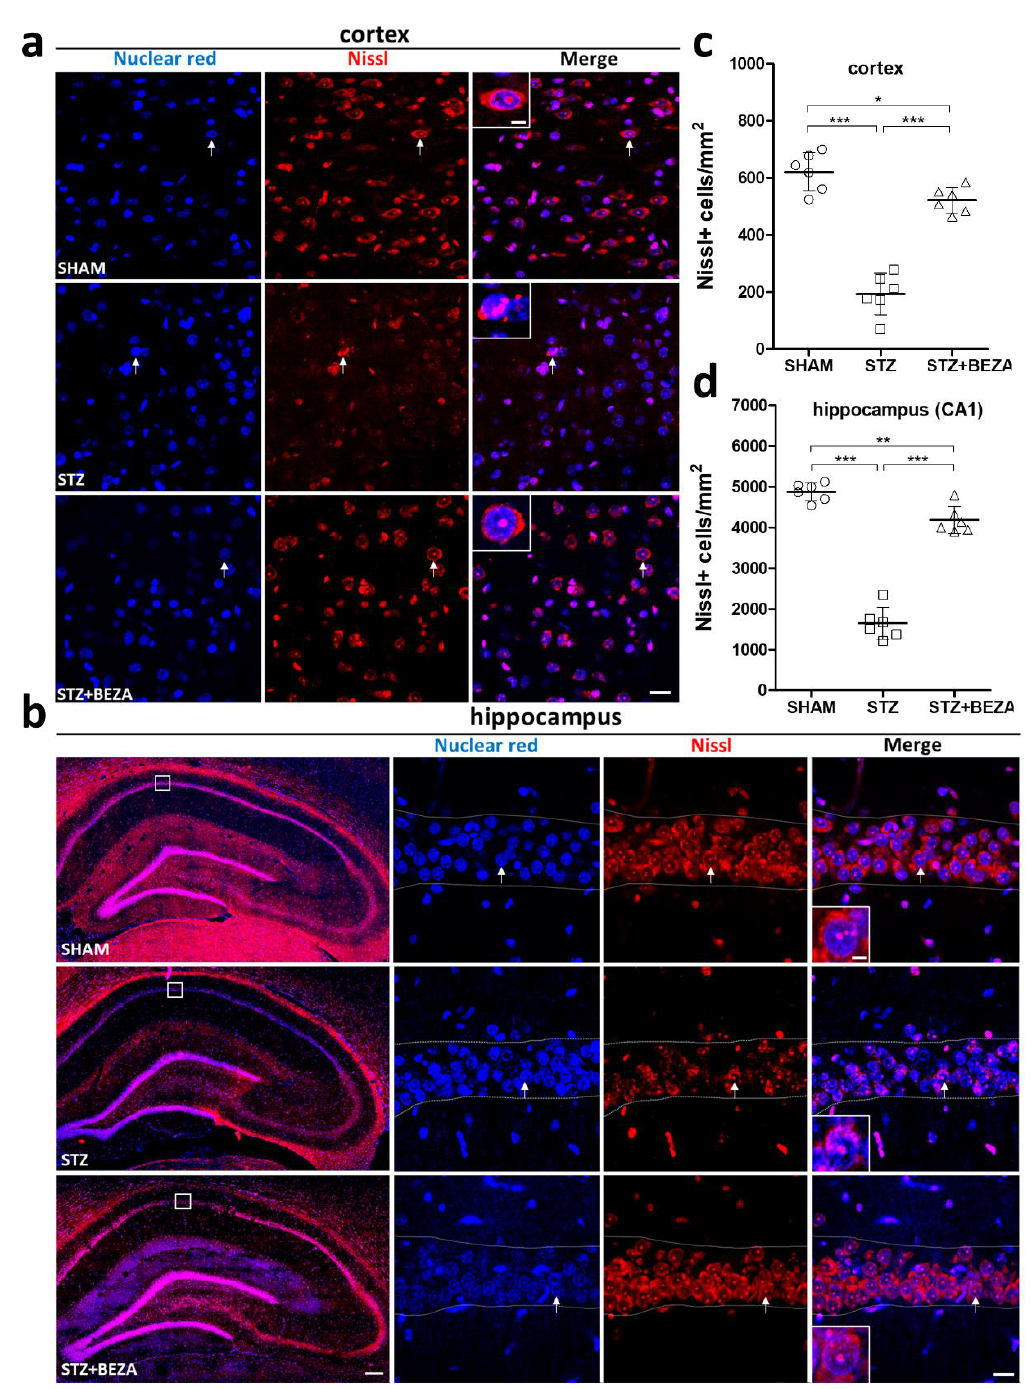
Figure 2. Bezafibrate mitigated the STZ-ICV-induced brain neuronal loss. Neuronal survival was evaluated by immunofluorescence staining with Nissl stain (red, for neurons) and nuclear red (blue, as nuclear counterstain). The Nissl staining-positive cells in the cortex ( a ) and hippocampus ( b ) of the STZ group (middle rows) were significantly fewer than those in the SHAM group (upper rows). The STZ+BEZA group (lower rows) demonstrated considerably preserved Nissl-positive cells in both the cortex and hippocampus. Quantitative analysis demonstrated that STZ-ICV administration